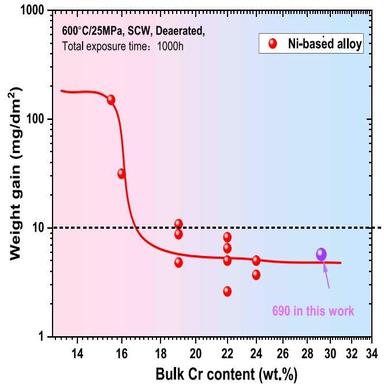
The weight gains as a function of Cr content after being exposed to 600 ◦C deaerated SCW for 1000 h.